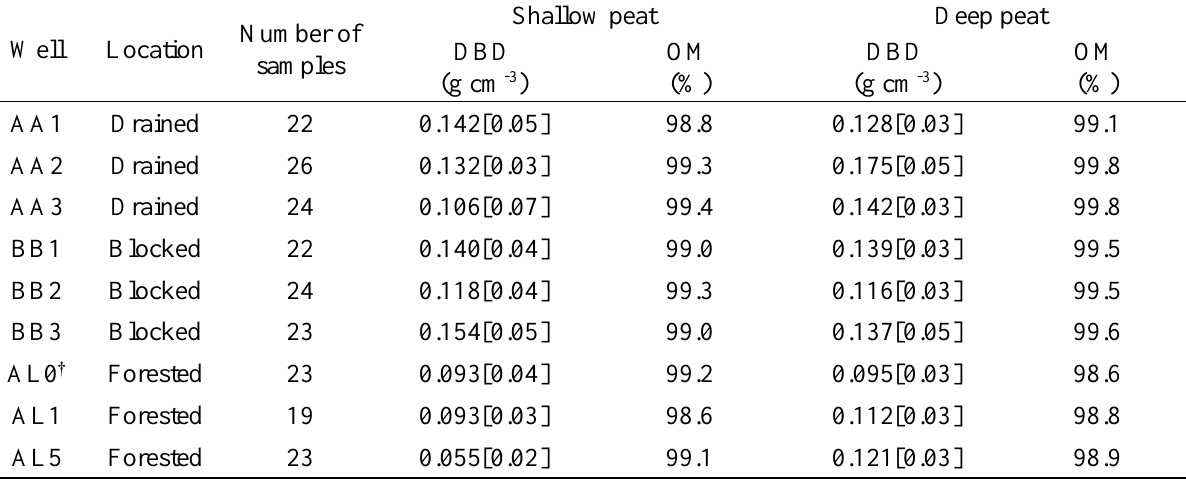
Table 5. Mean dry bulk density (DBD) and organic matter content (OM) of peat at the study sites. Standard deviation values are in brackets. The ground surface at AL0 (†) was on the bed of a small trench, 64 cm below the surrounding peat